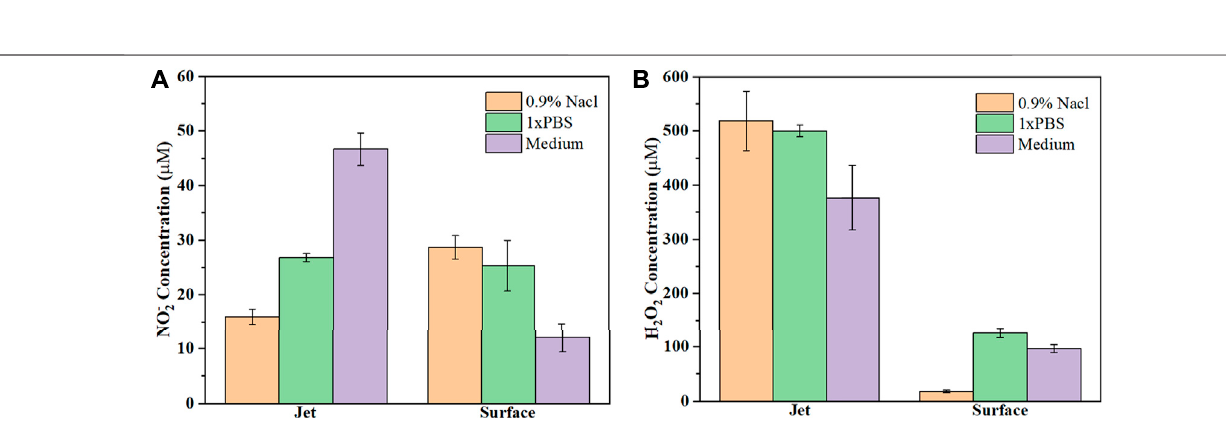
Frontiers in Physics |